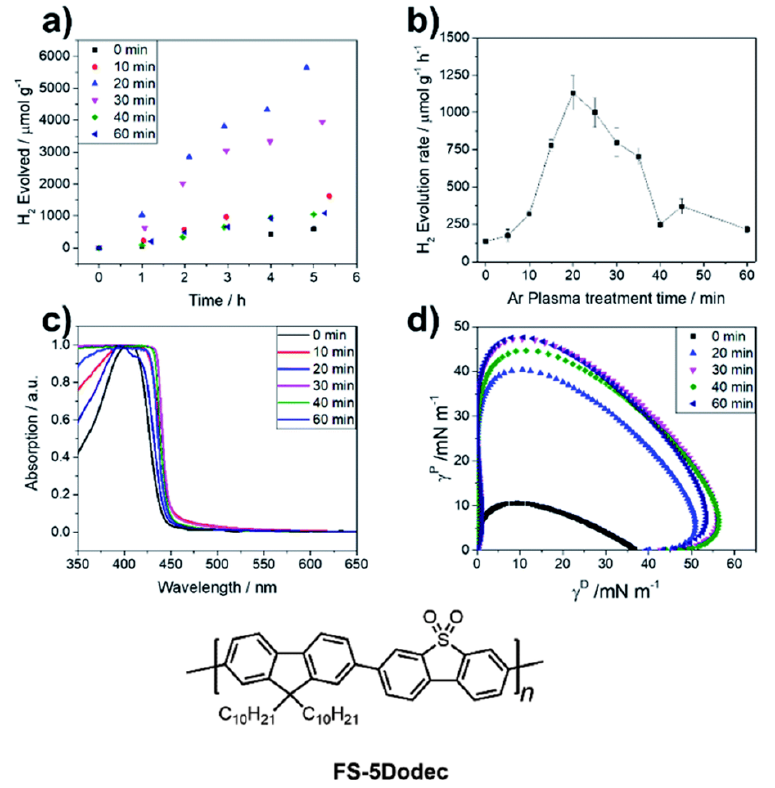
Figure 15. Plasma treated FS-5Dodec ( a ) Hydrogen evolution performance under visible light. Conditions: Drop-cast films on glass, 5 vol% triethylamine in water, λ > 420 nm, 300 W Xe light-source; ( b ) Correlation of the plasma treatment time and the hydrogen evolution rate under visible light; ( c ) UV-Visible absorption spectra; ( d ) Wetting envelopes of the polymer films. Below: Structure of FS-5Dodec [Adapted figure from ref. [101]].